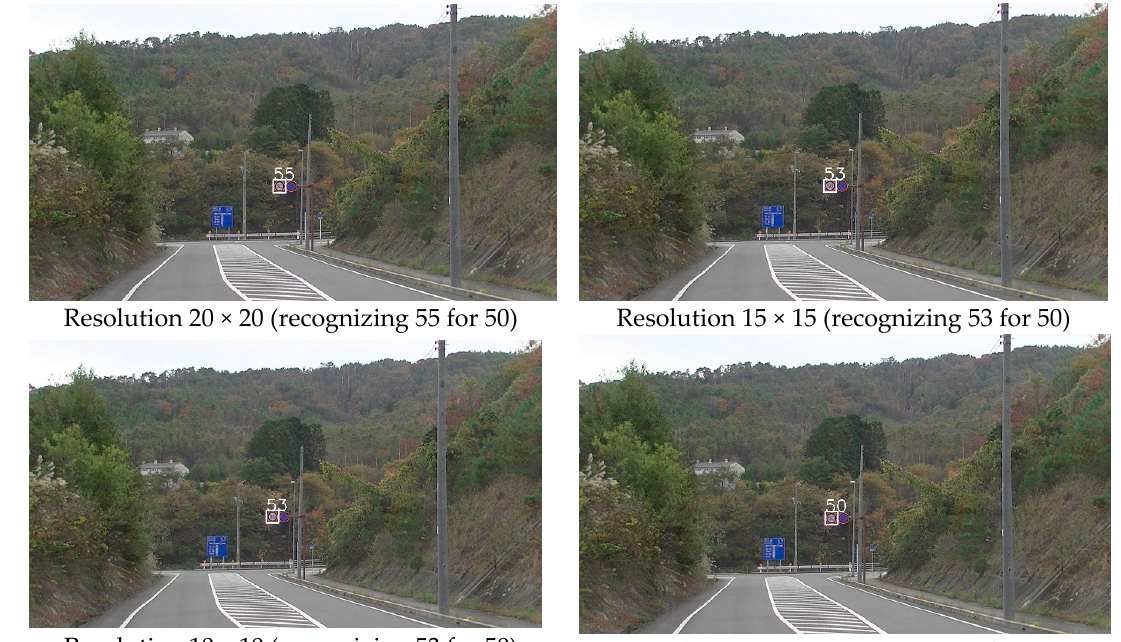
Figure 18. Example of recognition results for 40 km speed-limit sign.